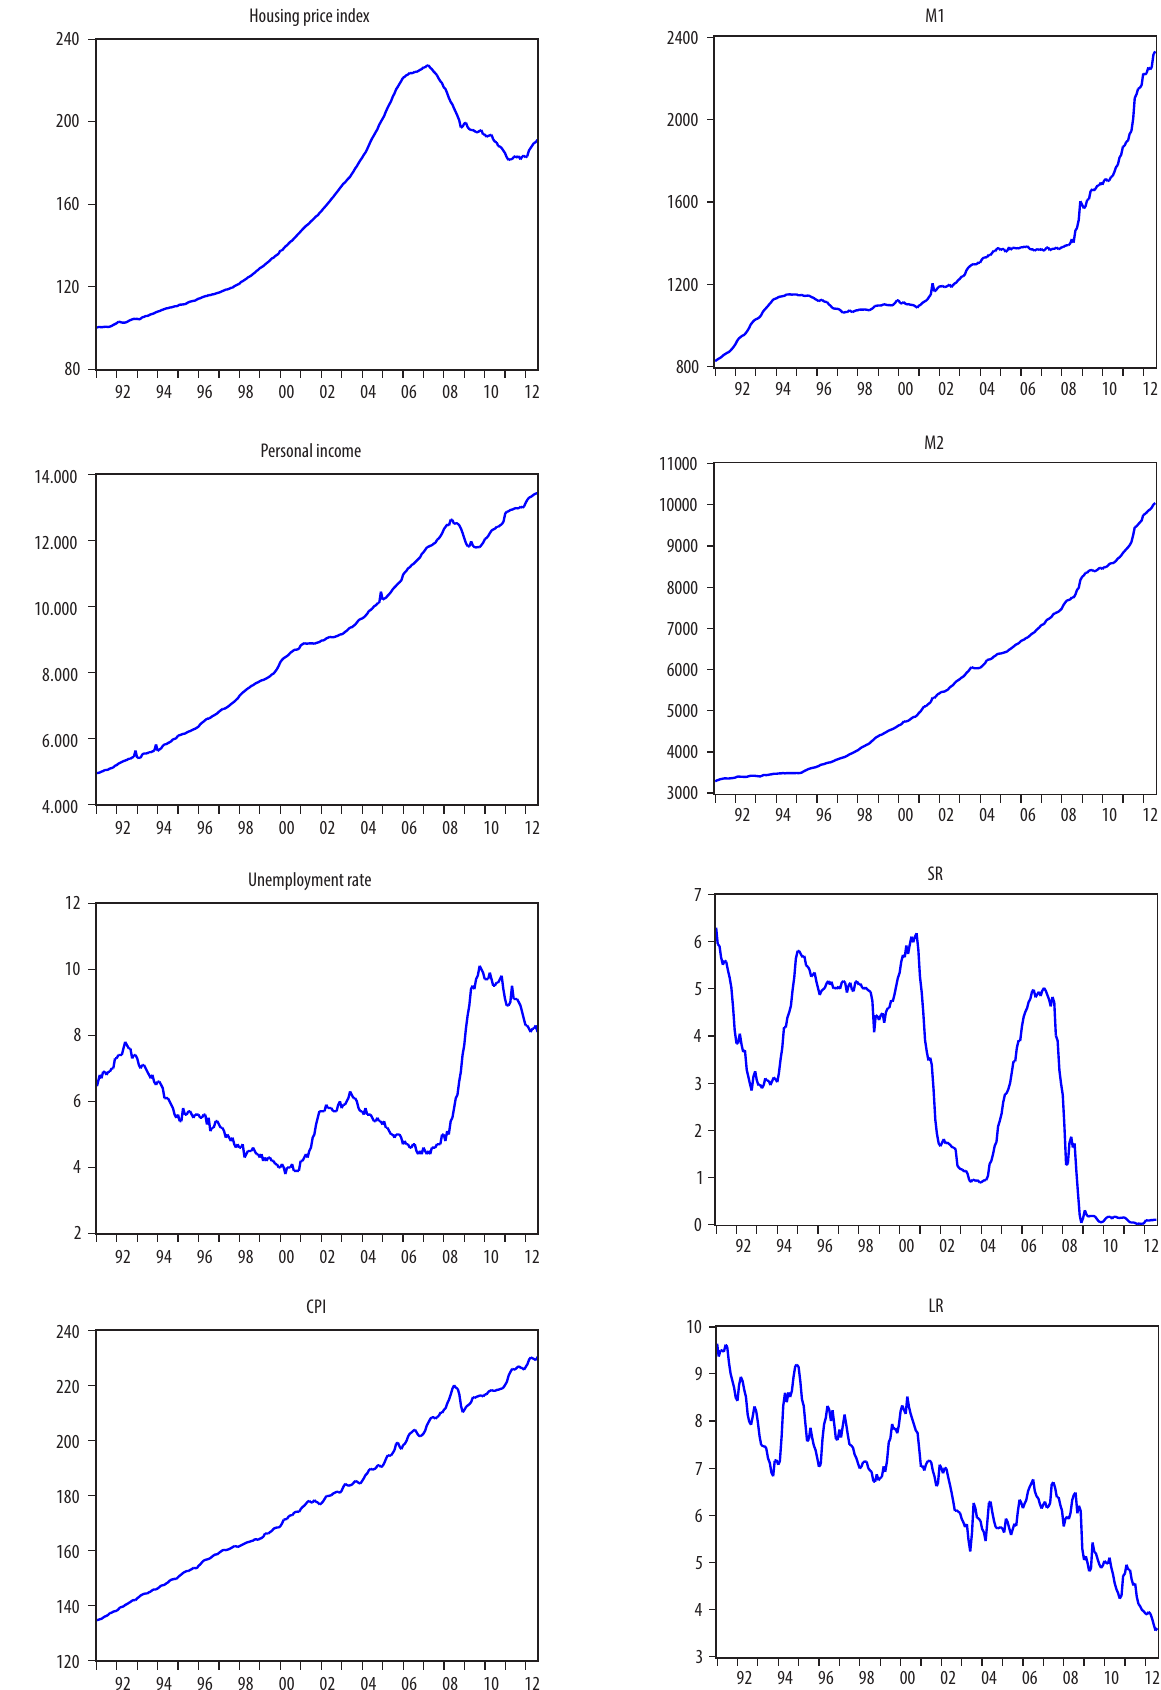
Fig. 2. Monetary policy related